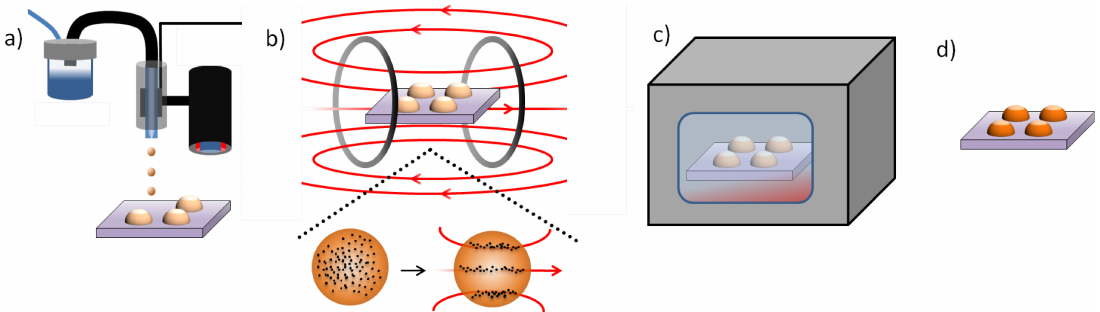
Figure 2. Fabrication process: ( a ) inkjet printing (IJP) of the SPMPC ( b ) exposure of uncured superparamagnetic polymer composite (SPMPC) to an external magnetic field provided by a Helmholtz coil setup ( c ) curing of the printed structures at 160 °C for 3 h in the oven ( d ) final structures with programmed preferential magnetic directions.